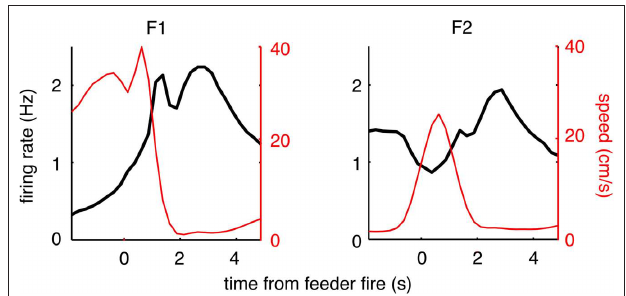
FIGURE 9 | Population reward response for all reward-responsive cells. At both reward locations a modulation in overall fi ring rate (black lines) was seen (left, feeder 1; right, feeder 2). The feeder 1 response appears to have two components to it: an early, sharp peak followed by a late, broader response. For feeder 2, the relative magnitude of these two responses was altered, such that the late, broad response dominates. Note how this late component does not appear to be related to instantaneous running speed (red